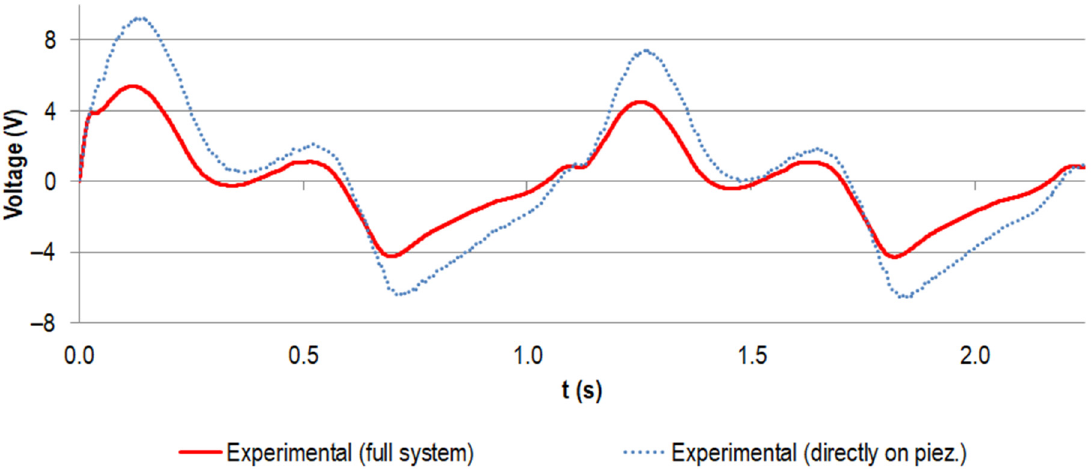
Figure 9. Experimental voltage data (V) for the first two gait cycles (time t in s) for the stacked configuration at a load resistance R of 0.5 M Ω . The curve for the implanted system is shown in red and the data for the directly loaded piezoelectric element are shown in blue (dotted line, same data as for Figure 8).